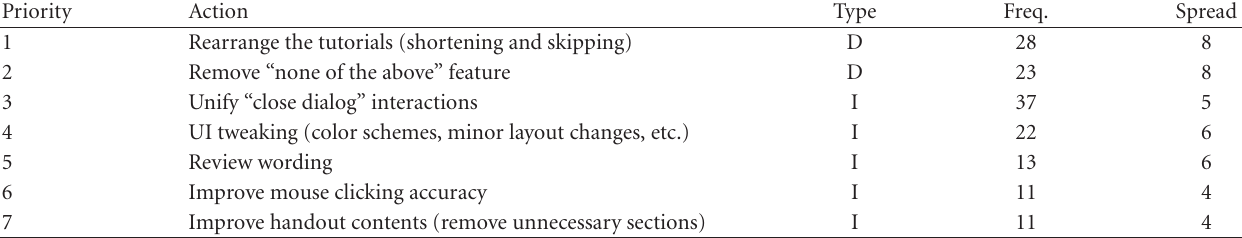
Table 3: Excerpt of the prioritized action points list. It shows the type (D: design/I: interface), the frequency (number of occurrences), the spread (number of users a ff ected), and the priority they were given according to these two numbers.